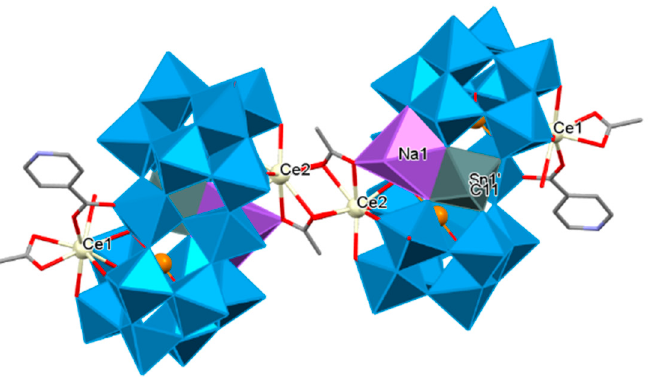
Figure 6. The dimeric skeleton of Na 2 {[Sn(CH 3 )W 2 O 4 (IN)][(B- α -TeW 8 O 31 )Ce(H 2 O)(OAc)] 2 } 2 [198]. [H 2 N(CH 3 ) 2 ] 8 K 2 Na 4 [RE 2 (OAc) 2 (H 2 O) 4 Fe 2 (2,5-pdc) 2 (B- β -TeW 9 O 33 ) 2 ][RE 2 (H 2 O) 8 Fe 2